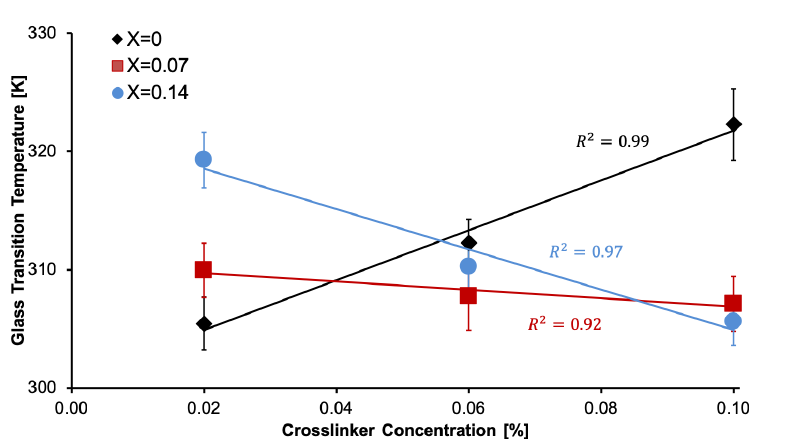
Figure 1. Experimental data of T g in crosslinked nanocomposite scaffolds. Three mass fractions of nanoparticles were measured: X = 0 , X = 0.07 and X = 0.14.